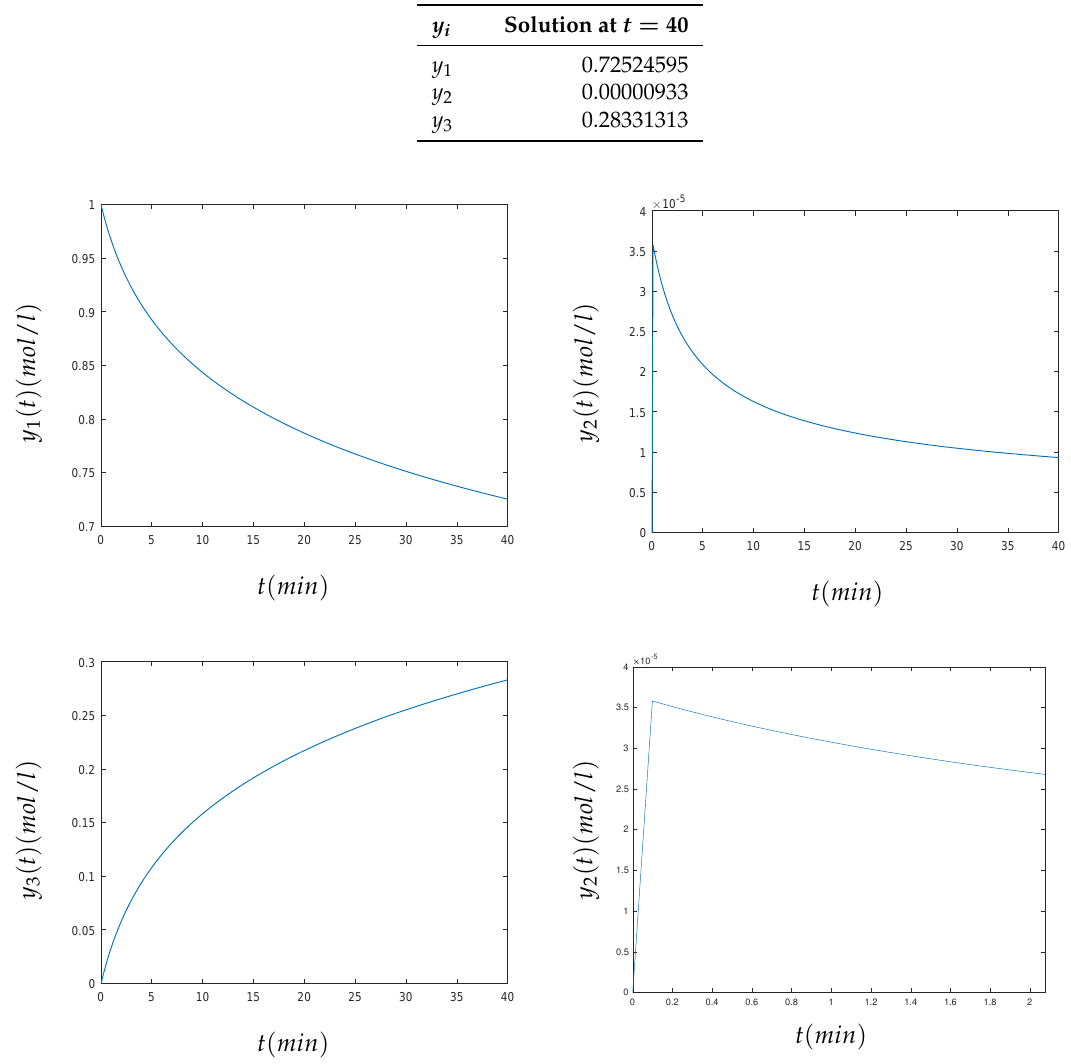
Table 1. Results of the Robertson problem at t = 40.